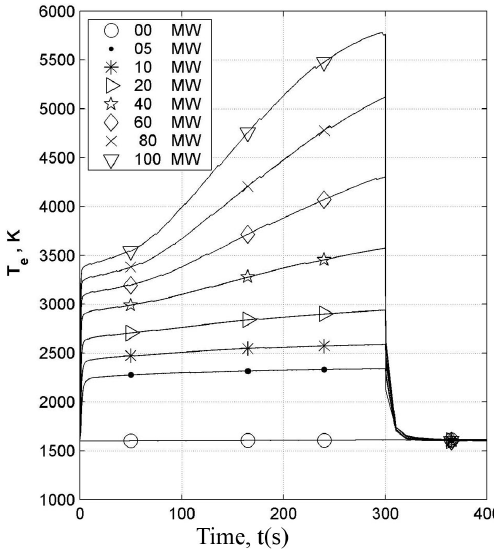
Fig. 7. The time variations of the electron temperature (in absolute degrees) at the level h = 235km. The results are given for different values of the EAP: 5, 10, 20, 40, 60, 80, and 100MW, with sym- bol 0MW indicating the results obtained under natural conditions without heating.